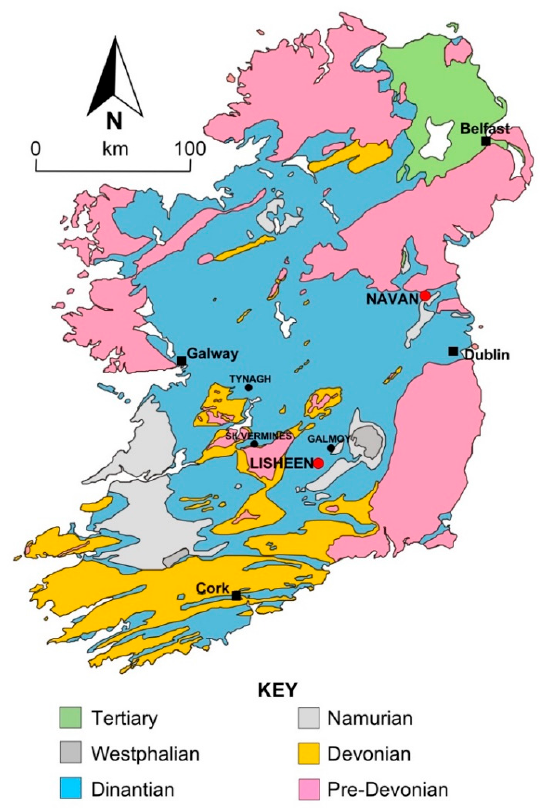
Figure 1. Simplified geological map of Ireland including the location of the Navan and Lisheen deposits (Modified from Gagnevin et al. [28]).